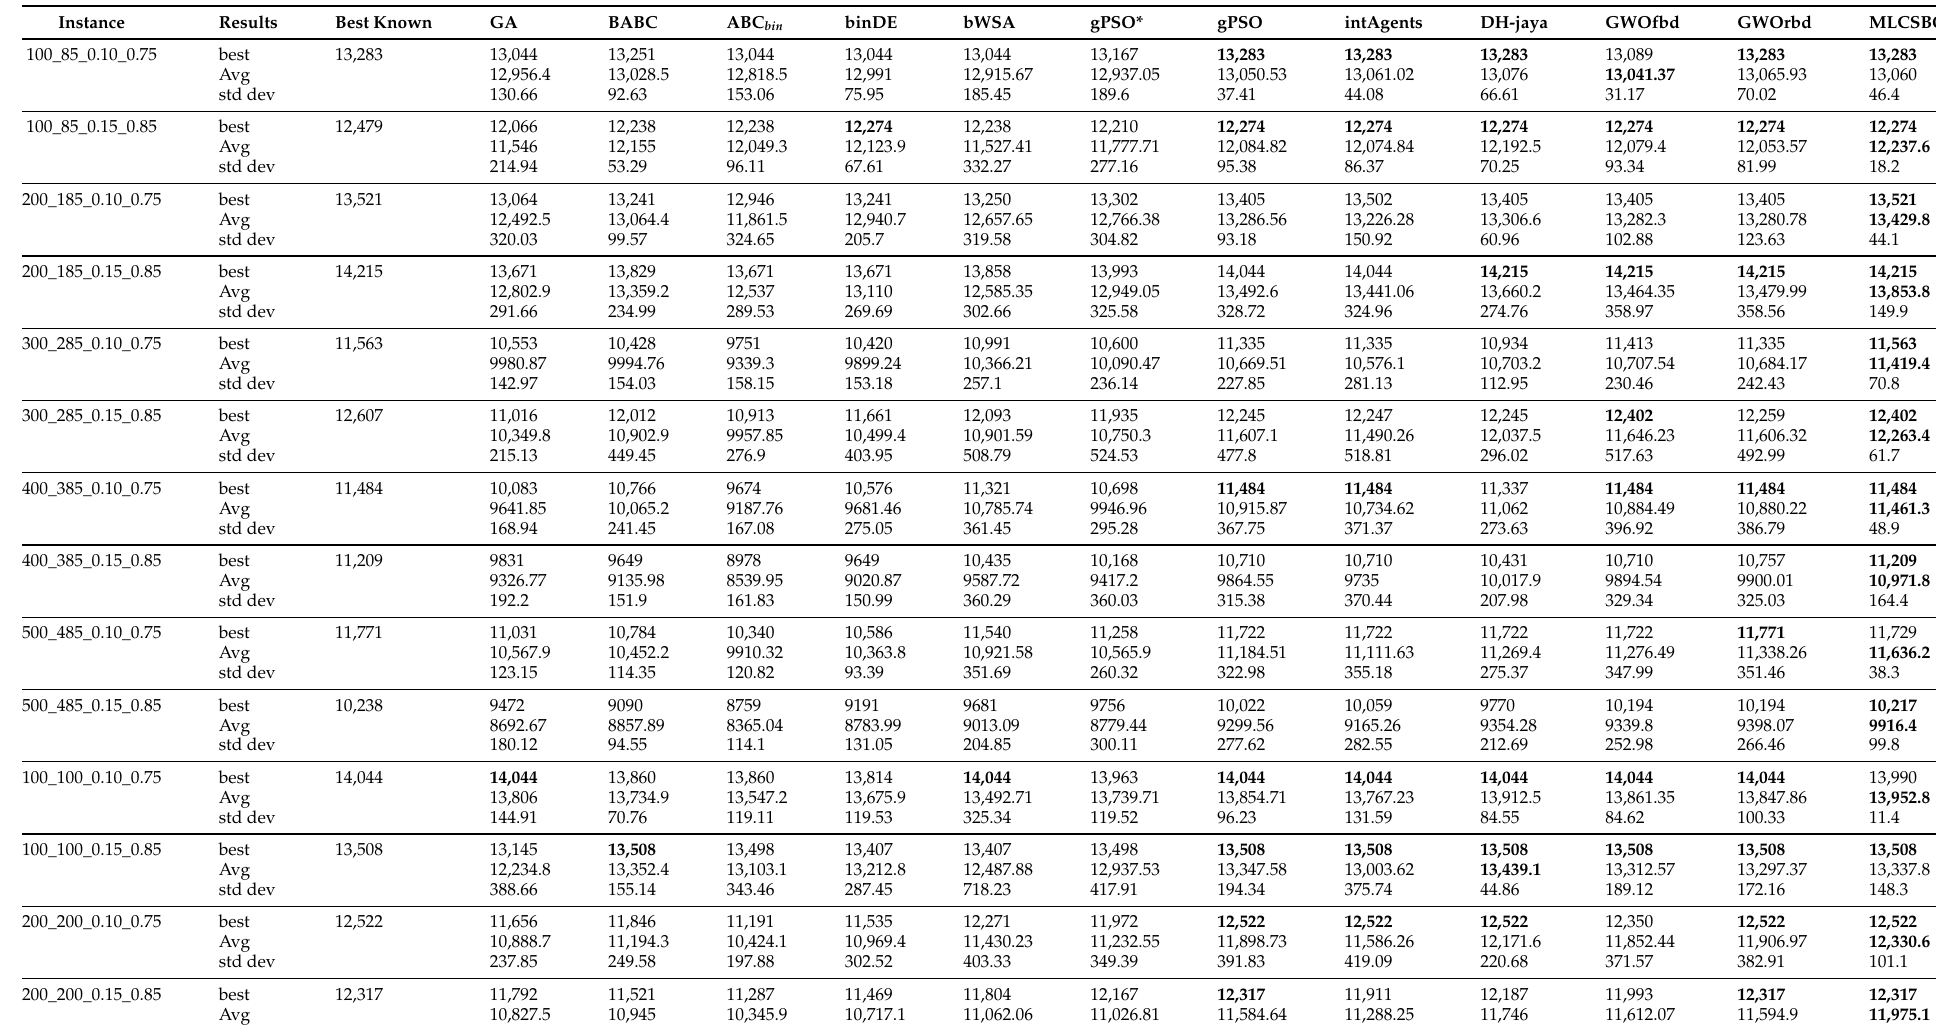
Table 6. Comparison between GA, BABC, ABC bin, gPSO*, gPSO, intAgents, DH-Jaya, GWOfbd, GWOrbd and MLCSBO algorithms for medium